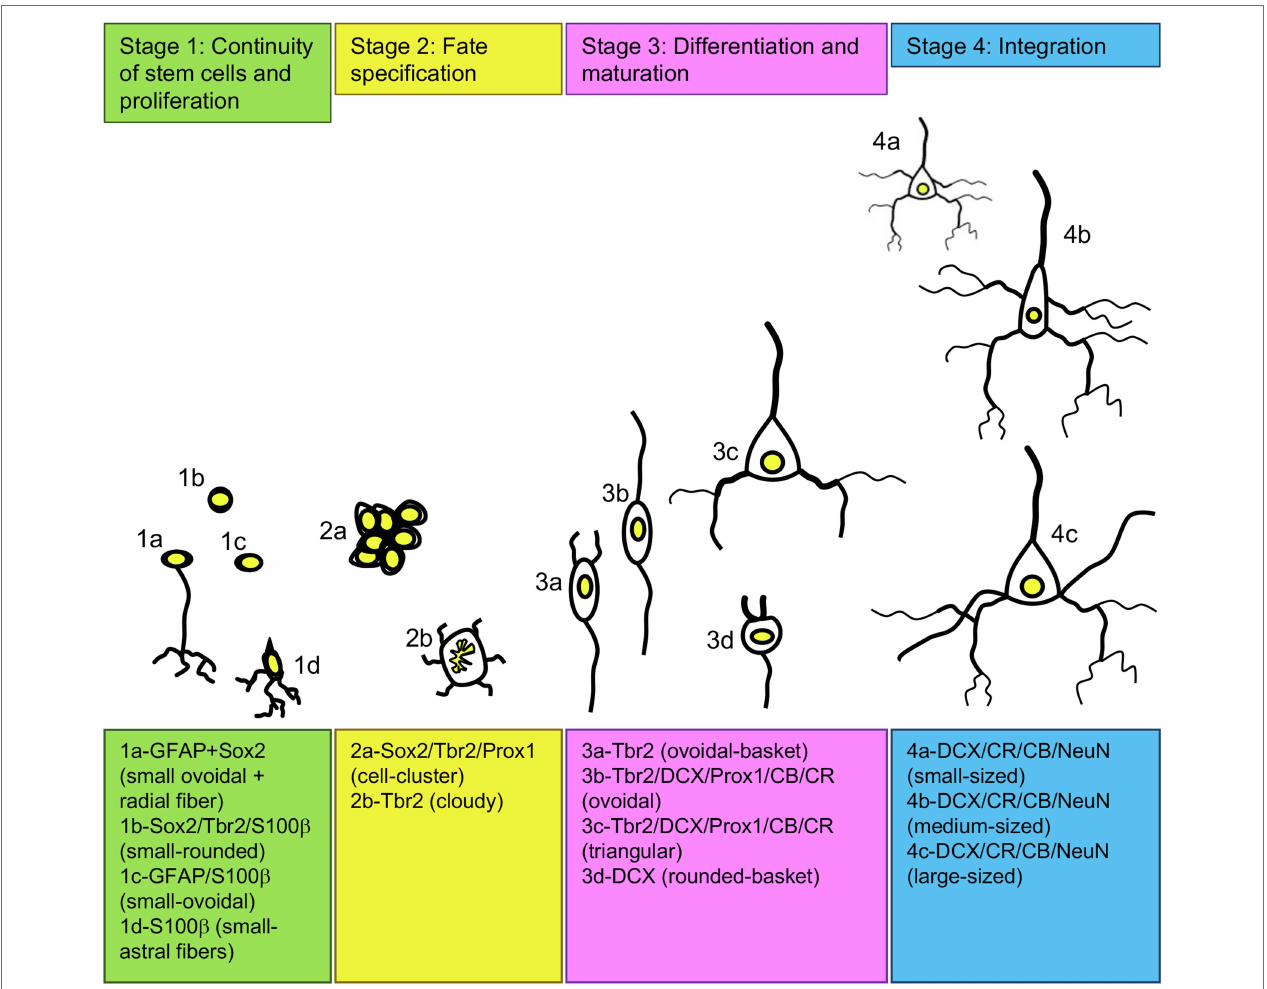
FIGURE 2 | Adult neurogenesis in the pigeon forebrain. Schematic of different developing cell types in the adult pigeon telencephalon that are organized in four stages of neurogenesis based on their shape, size and expression of transcription factors and neurogenic or gliogenic marker proteins. For abbreviations see